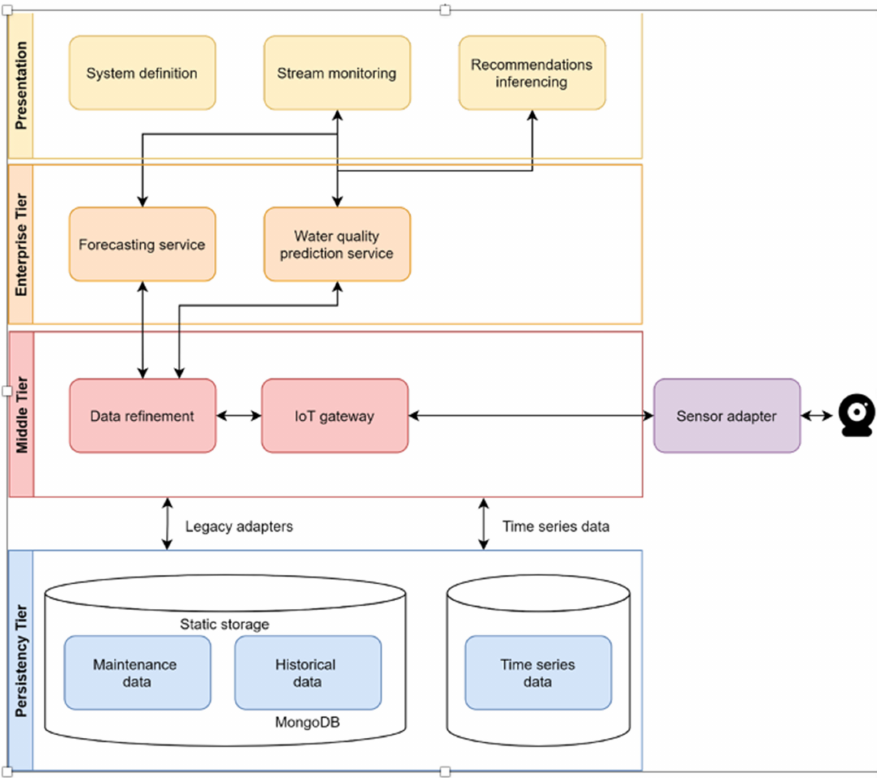
Figure 3. DSS Overall